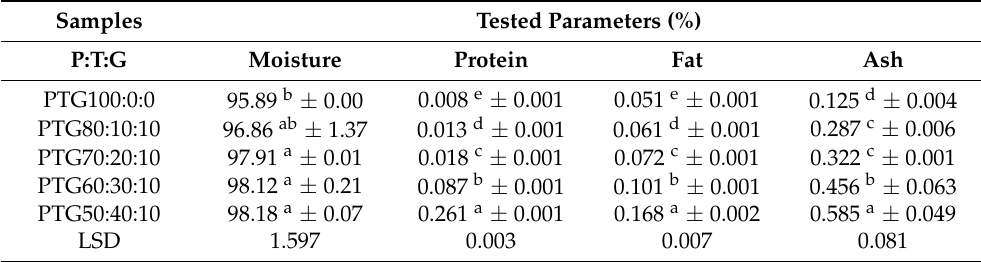
Table 3. Proximate variations of Ginger, Pineapple, and Tumeric Juice Mix as influenced by Blends.